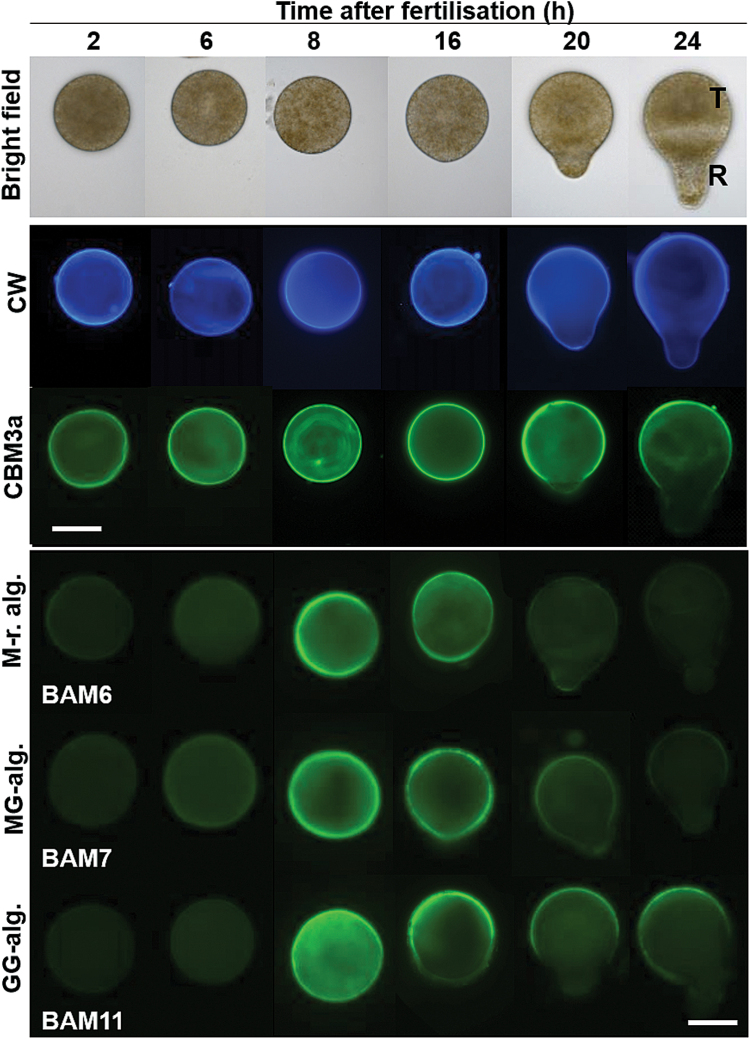
Indirect immunofluorescence labeling of cellulose and alginate populations in developing Fucus serratus zygotes. Bright field images on the top panel show the morphology of the zygote and early embryo at time points after fertilization. Beta-linked glucans were detected by use of Calcofluor White stain (blue fluorescence) and the carbohydrate-binding module CBM3a (green fluorescence). Detection of the BAM6, BAM7, and BAM11 alginate epitopes in equivalent individuals. T, thallus cell; R, rhizoid cell. Scale bars=50 µm.